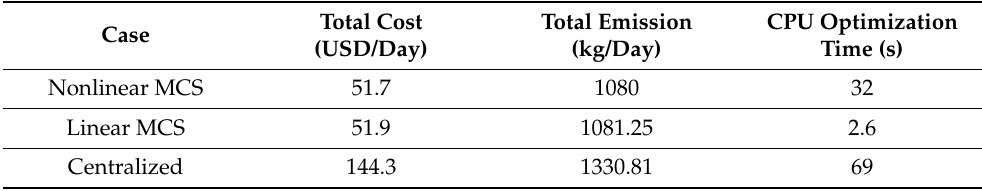
Table 2. Results of the proposed MCS-based method and centralized